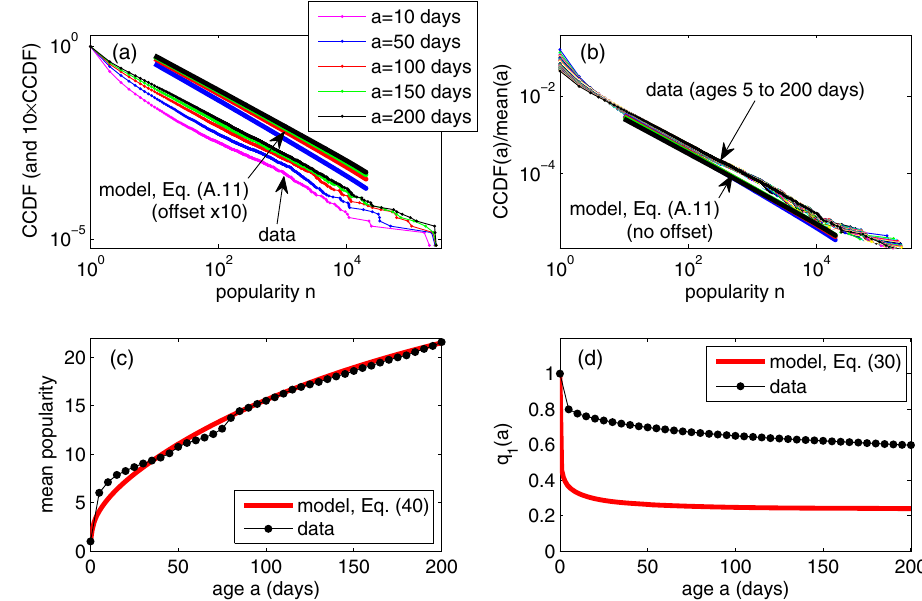
FIG. 6. Comparison of the model with Twitter hashtags data. (a) CCDFs for popularity of hashtags at age a (at time a after their first appearance in the data set). The model CCDFs [from Eq. (A11)] are multiplied by 10 for clarity. Model parameters are λ ¼ 4 . 5 × 10 − 4 , μ ¼ 0 . 033 , k 0 . 25 , θ ¼ 500 , with one model time unit corresponding to 0.16 days. (b) CCDFs at age a , each divided by the mean G ¼ popularity at age a . The data show an apparent collapse onto a single curve that is closely matched by the model. (c) The mean popularity of hashtags of age a . (d) The fraction q 1 ð a Þ of hashtags that are not retweeted by age a . Here, our basic model with homogeneous user activity rates does not fit well to the data (but see Fig.